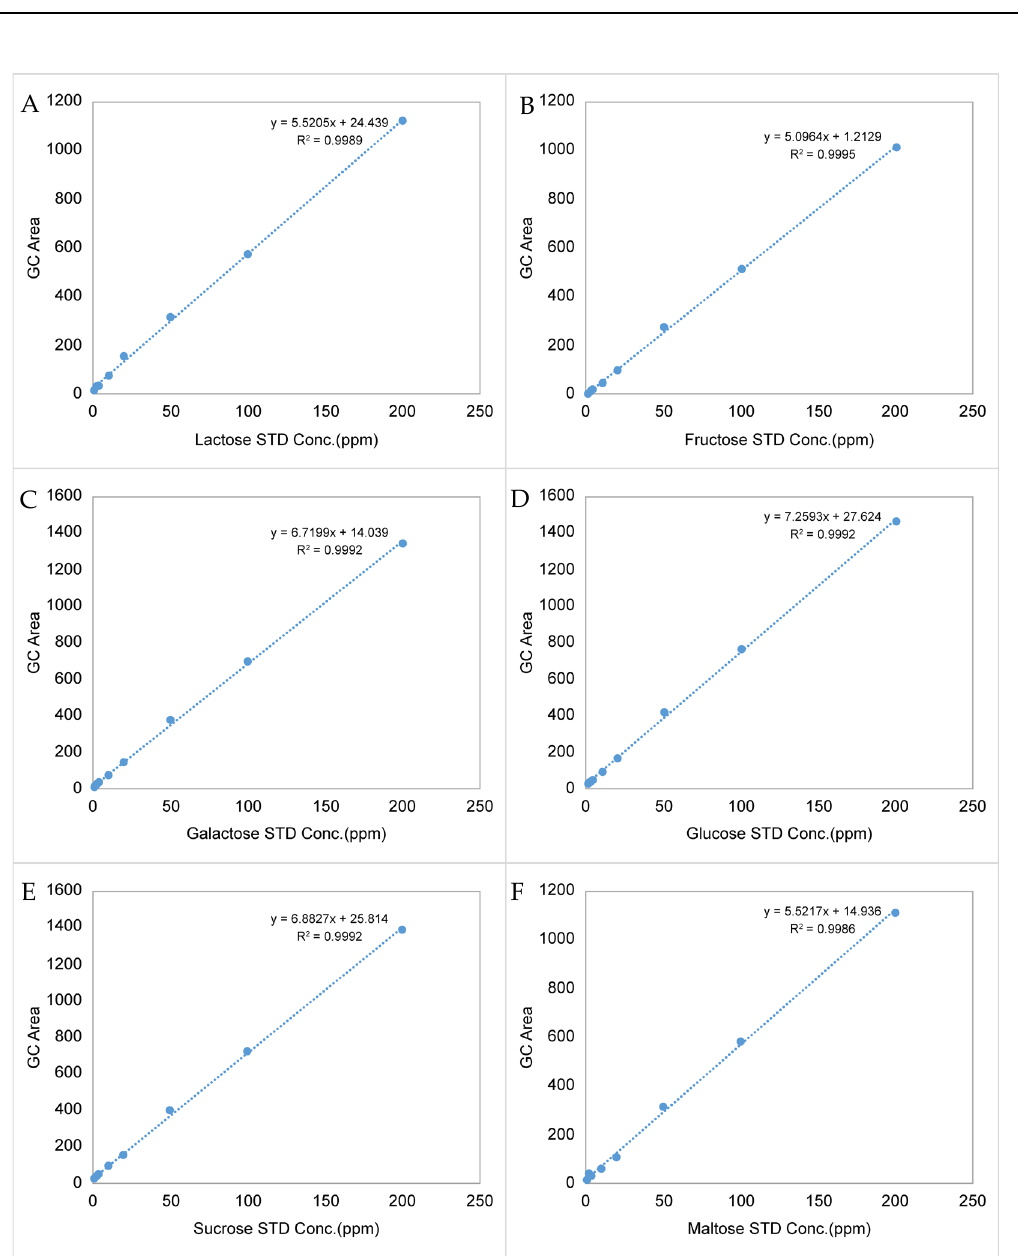
Figure 2. Linearity and determination coefficients (R 2 ) of the calibration curves for six major free sugars by GC/FID. A = lactose, B = fructose, C = galactose, D = glucose, E = sucrose, F = maltose, IS = Internal Standard.